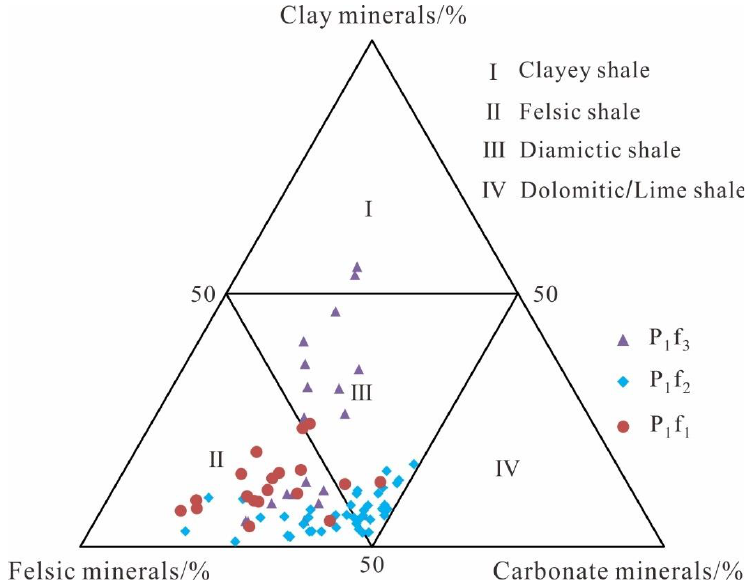
Figure 3. Rock names and classification for the shale formation of Mahu Sag.